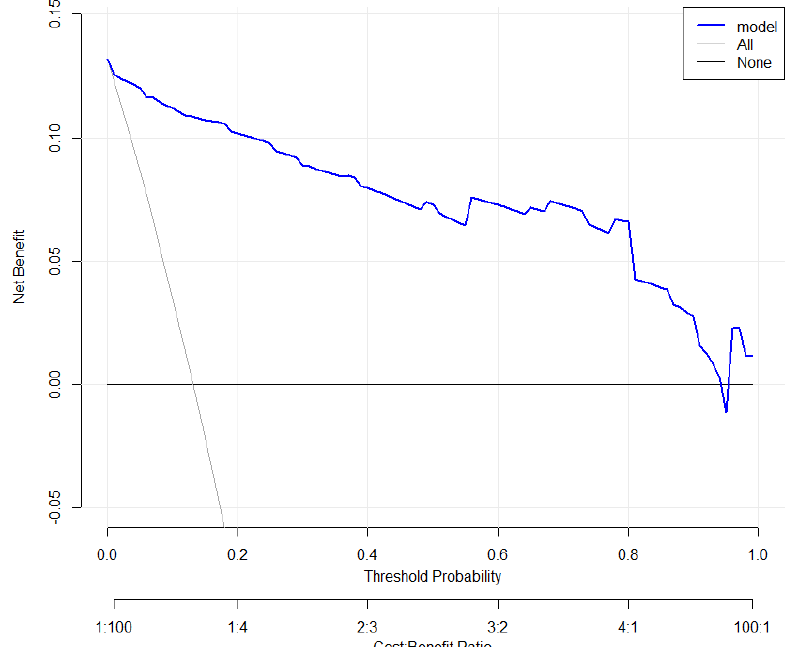
ogram was more beneficial than the treat-none scheme or the treat-all-patients scheme.